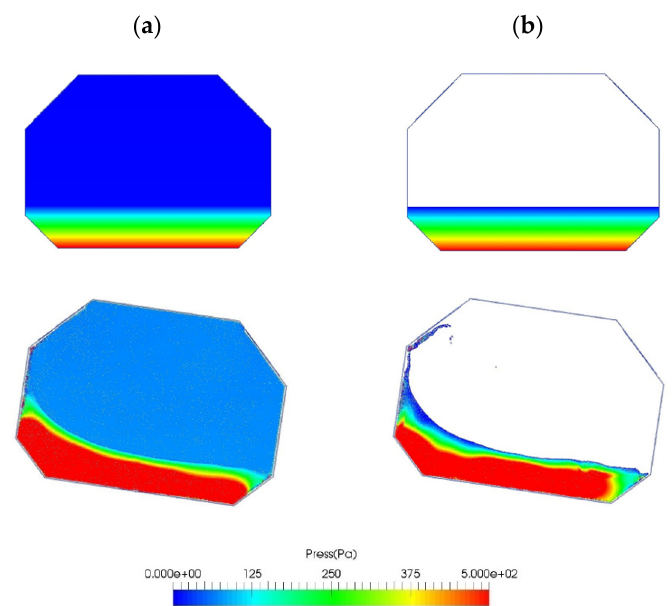
Figure 12. Pressure contour under roll oscillation for ( a ) two-phase SPH and ( b ) single-phase SPH at t = 0.0 seconds and 11.4 seconds.